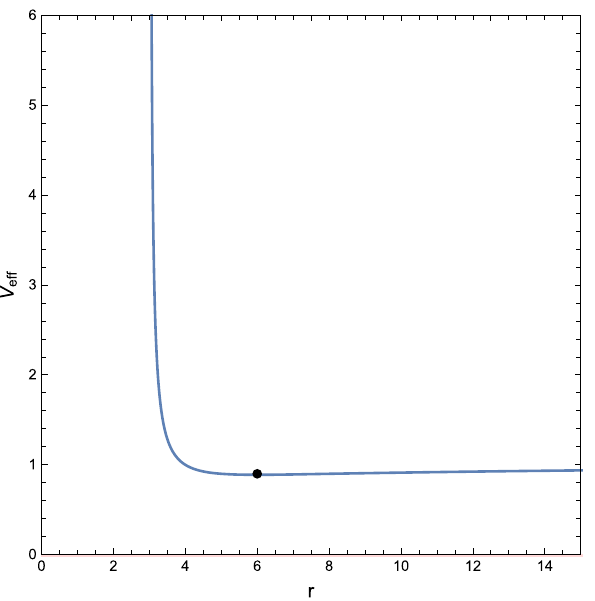
Fig. 6 Effective potential for the first case with L = 1. The dots indi- cate the location of the stable circular orbits for the black hole in dRGT massive gravity, r SCO = 0 . 44 and r SCO = 1 . 15 locations of the stable circular orbits for the two cases and we show those points using the black dots in Figs. 6 and